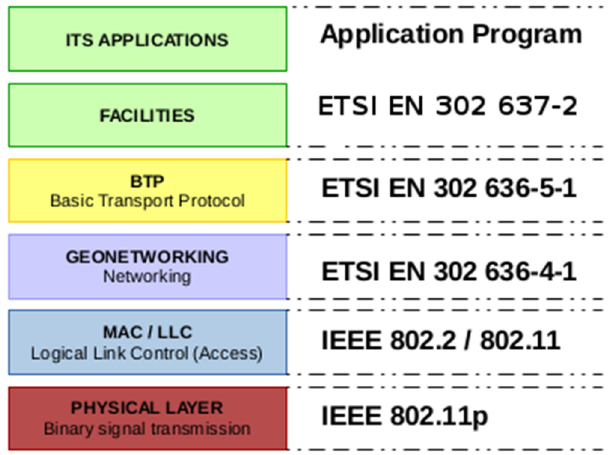
Figure 2. Open System Interconnection (OSI) model of Geonetworking protocol. MAC: Medium Access Control.